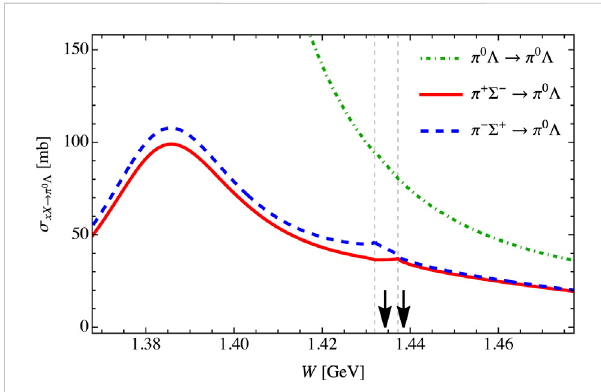
FIGURE 5 Cross sections (containing S- and P-waves) for different initial states to the π 0 Λ fi nal state with respect to fi t scenario F 1 (all data fi t). Dashed vertical lines show positions of K − p and (cid:1) K 0 n thresholds, while the black arrows indicate the positions of the possible isovector resonances from Ref.